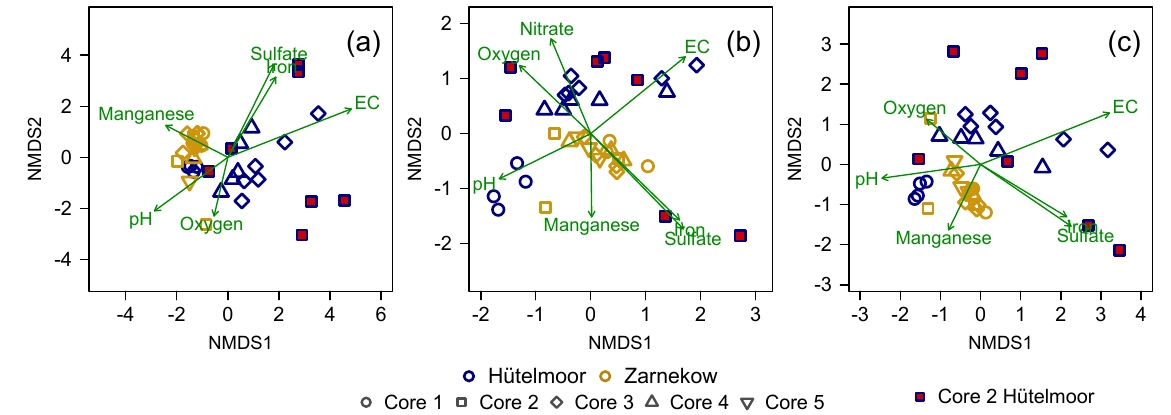
Figure 6. NMDS plots showing (a) bacterial, (b) archaeal, and (c) microbial (bacterial plus archaeal) community composition across the nine peat cores. The point positions represent distinct microbial communities, with the border colors of the symbols referring to the study sites and their shapes representing the core number. HC 2 symbols are highlighted with red fill to emphasize the large variation in microbial community within the core. Environmental fit vectors with a significance of p < 0 . 05 are shown in